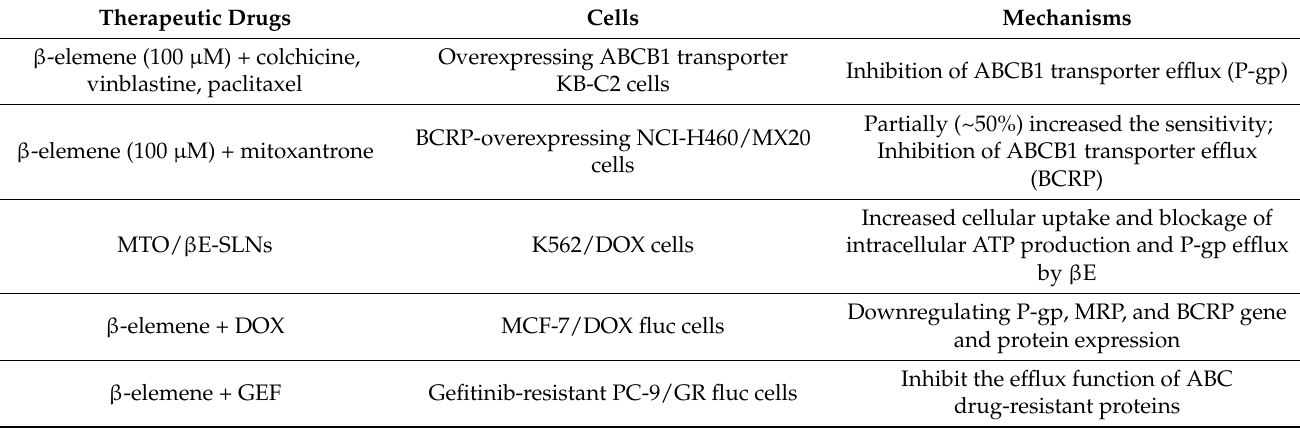
Table 2. Mechanisms of inhibition of ABC transporter efflux by β